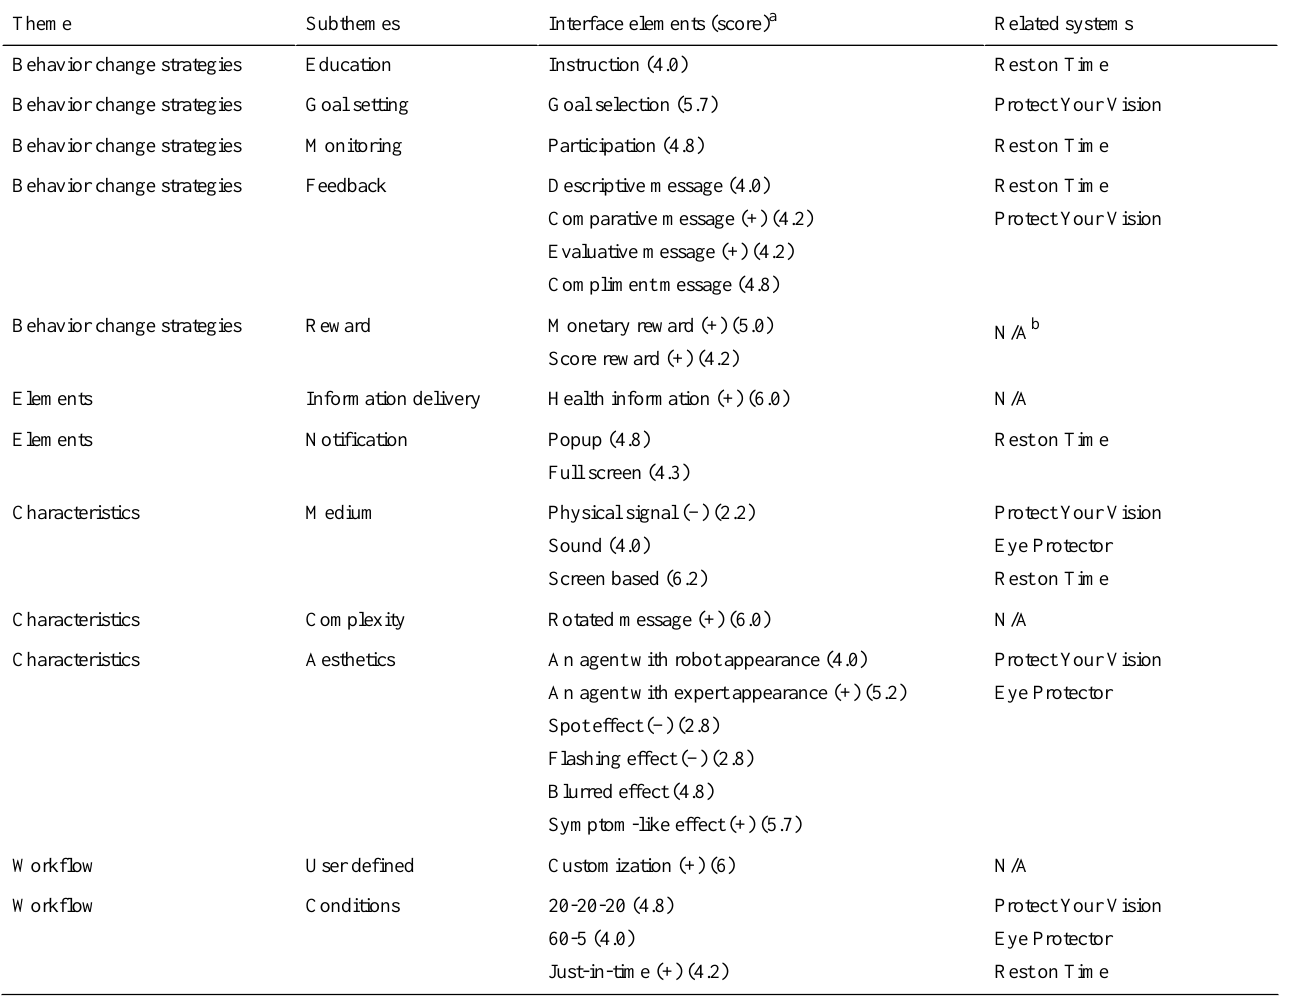
Table 3. List and scores of interface elements that resulted from the focus group